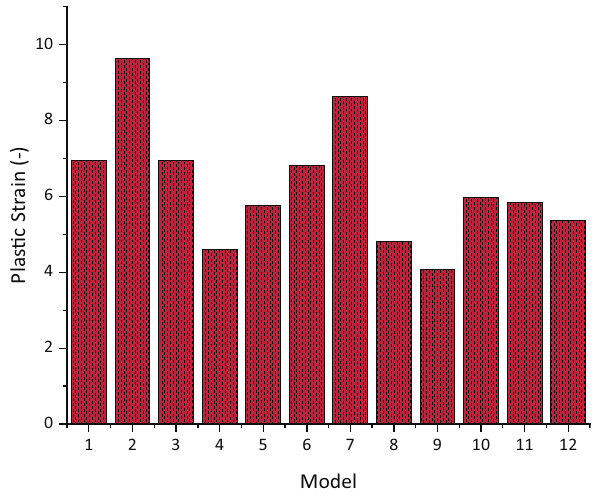
Figure 13: Average plastic strain value for every